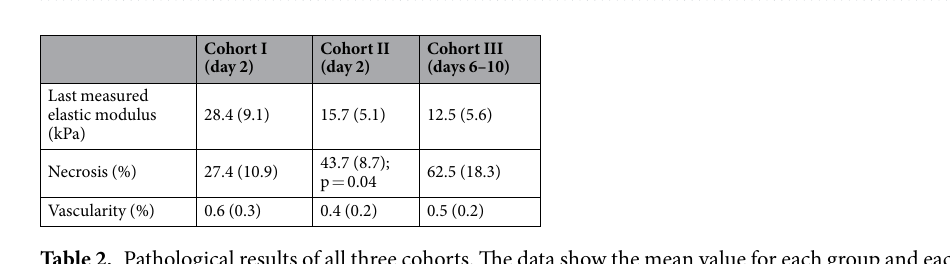
Figure 6. Necrosis as a function of elastic (Young’s) modulus. ( A ) Cohort I ( ) and II ( ). ( B ) Cohort III.